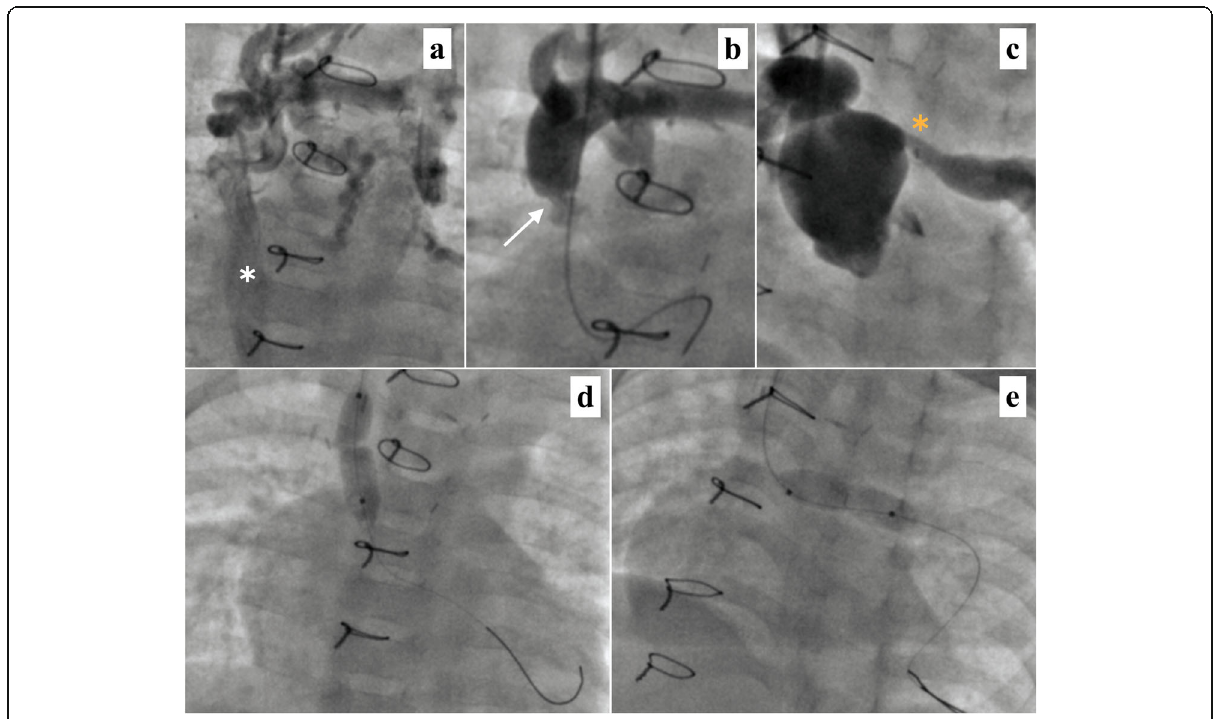
Fig. 4. Opening-up of obstructed Glenn: a Injection in the upper part of right superior vena cava shows diffuse meshwork of venous collaterals mostly draining into the azygous venous system (white asterix). b Significant narrowing (white arrow) of the right superior vena cava and right pulmonary artery anastomotic site. c Pulmonary angiogram showing severe proximal left pulmonary artery stenosis (yellow asterix). d Balloon angioplasty of the Glenn anastomotic site. e Balloon angioplasty of the proximal left pulmonary artery